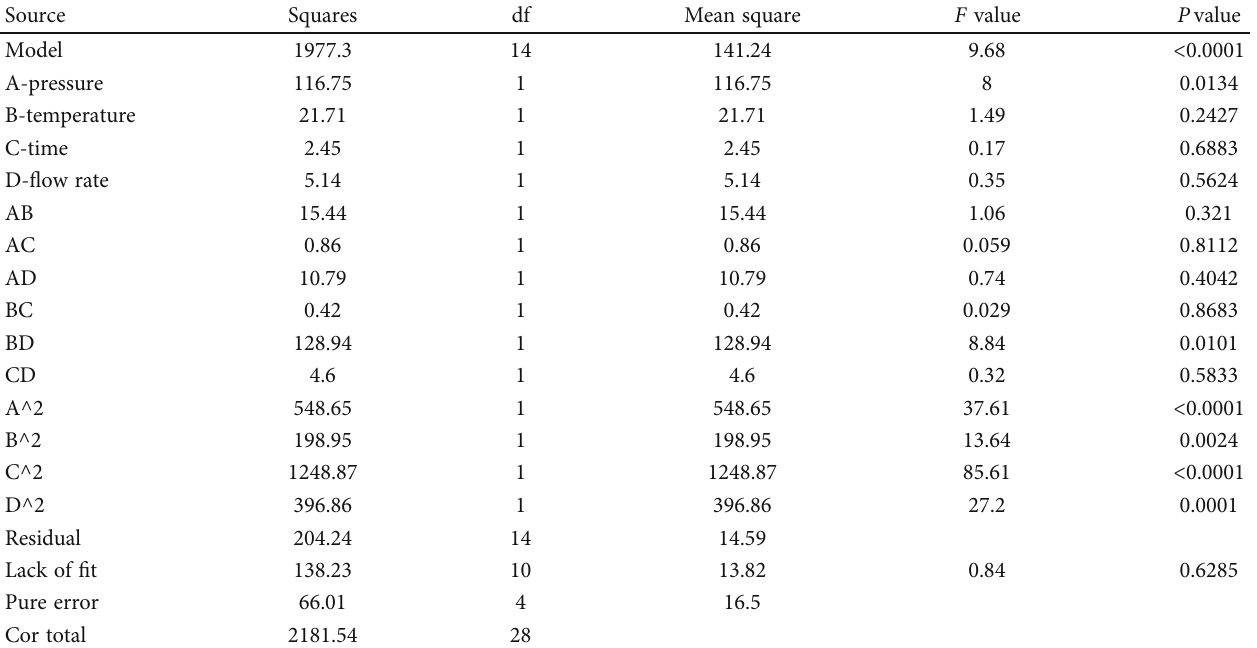
Table 4: Response face quadratic regression